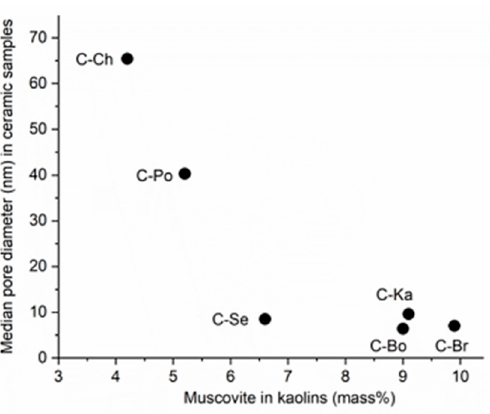
Figure 7. Median pore diameter in ceramic samples changing with content of muscovite in kaolins.